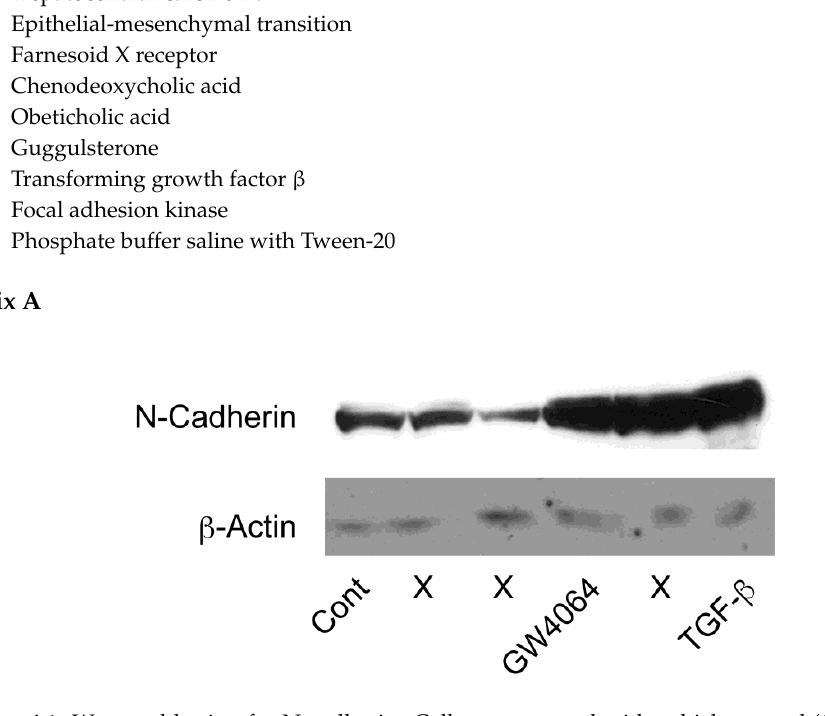
Figure A1. Western blotting for N-cadherin. Cells were treated with vehicle control (Cont), 10 μM GW4064, or 10 ng/mL TGF-β for 48 h. Lanes indicated with an X were not subjected for evaluation.